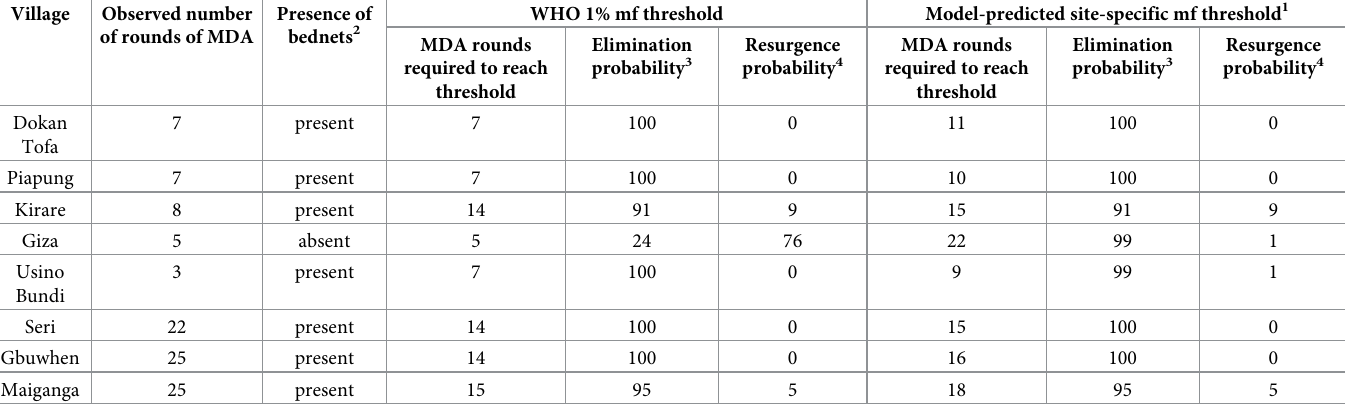
Table 5. Probabilities of elimination and resurgence after the 5-year TAS period when MDA is stopped at 1) the WHO 1% mf threshold and 2) the model-predicted mf thresholds. Village Observed number Presence of of rounds of MDA bednets